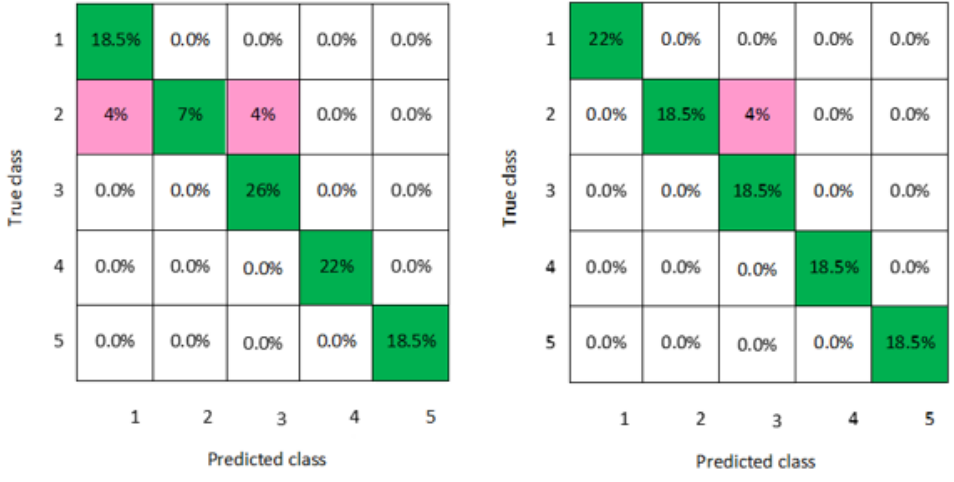
Figure 6. Medium Gaussian SVM confusion matrixes for men and women data, respectively.